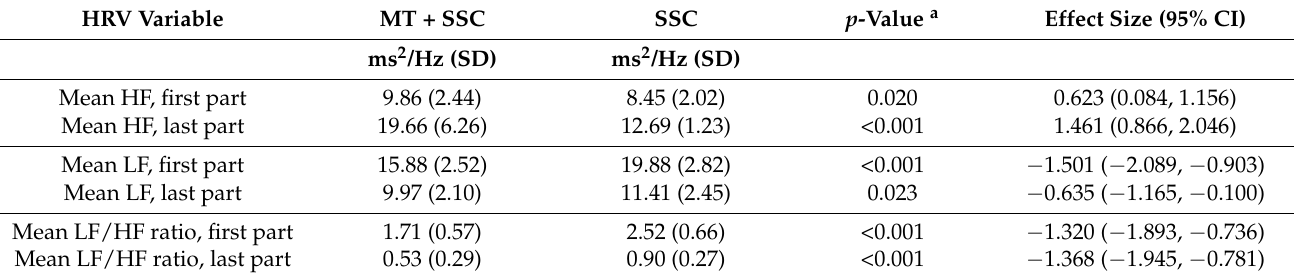
Figure 1. HRV parameters during the second session. ( a ): Primary outcome—Change in HF parameters during the second session; ( b ): Change in LF power; ( c ): Change in LF/HF ratio. During MT, the observed mean values of HF increased by 9.8 ms 2 /Hz from 9.86 in the first part of session to 19.66 in the last part, compared to a smaller increase of 4.24 ms 2 /Hz from 8.45 to 12.69 during SSC, with between-group effect size during the last part of the session of d = 1.46 (95% CI 0.87 to 2.05; Table 3). Table 3. Observed values of HRV parameters in the second session.